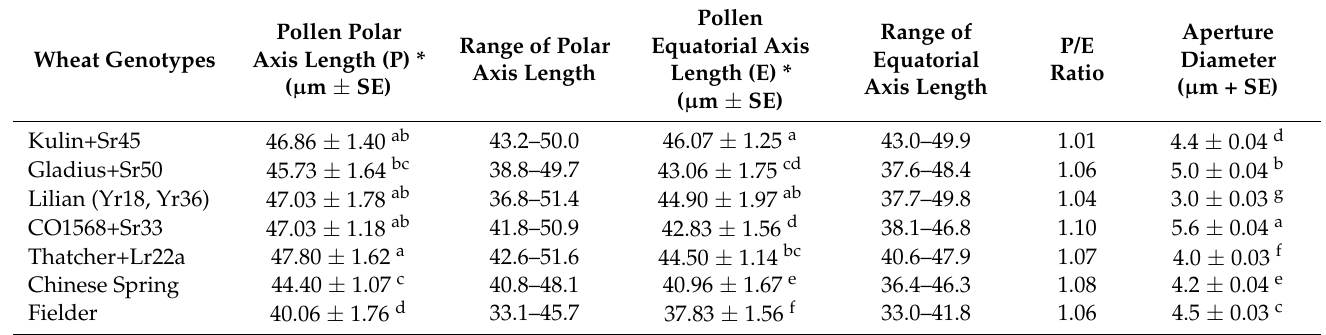
Table 1. Pollen morphology of seven wheat genotypes based on Scanning Electron Microscopy (SEM).